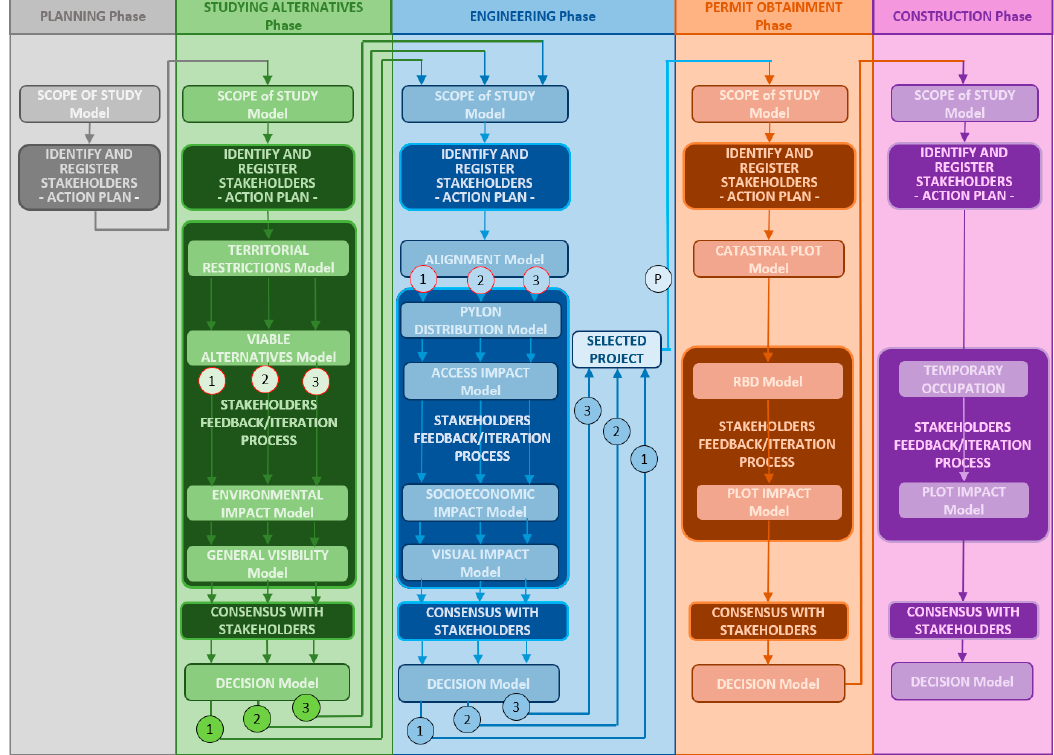
Figure 9. Merging the geodesign-based workflow for HVTL, with the proposed geographic stakeholder management. Boxes in soft color are from the geodesign-based workflow for HVTL and boxes in dark color add the new functionality.